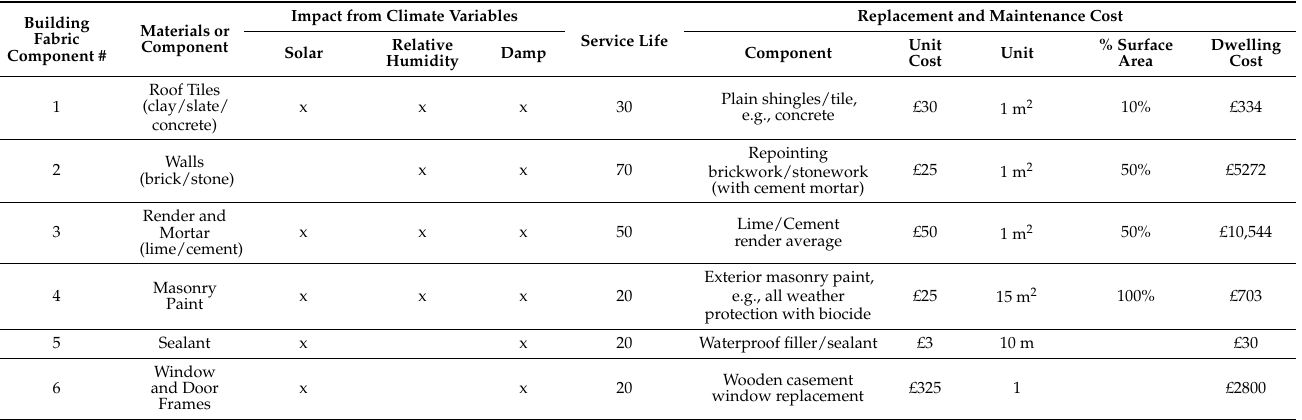
Table 3. Adjusted service lives for change in replacement costs by dwellingover the life of the building material.